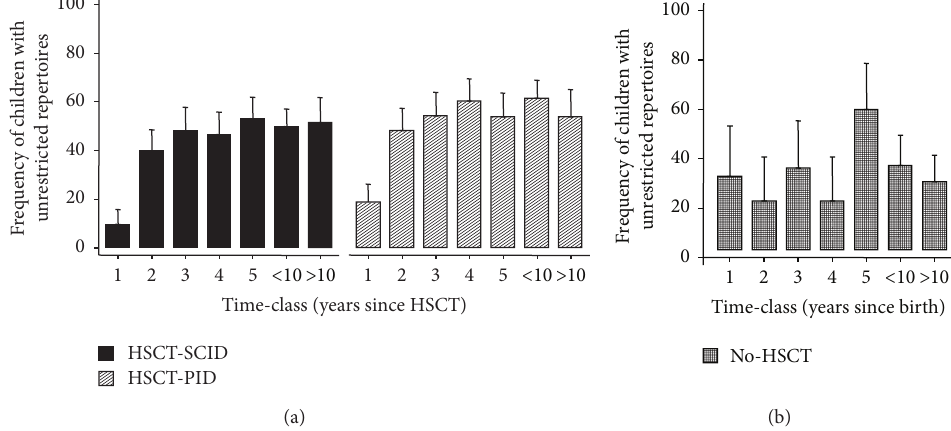
Figure 2: ((a) and (b)) Average frequency of children with SCID and PID receiving HSCT (HSCT-SCID and HSCT-PID, resp.) or that were not subjects to HSCT (no-HSCT) that show unrestricted T-cell repertoires. The indicated time-classes for HSCT children were calculated starting from the date of HSCT, whereas in no-HSCT children each time-class represents the age at the time of sampling. Time-classes were indicated as follows: 1: < 1 year, 2: < 2 years, 3: < 3 years, 4: < 4 years, 5: < 5 years, < 10: < 10 years, and > 10: > 10 years. Bars represent the means and error bars represent the standard